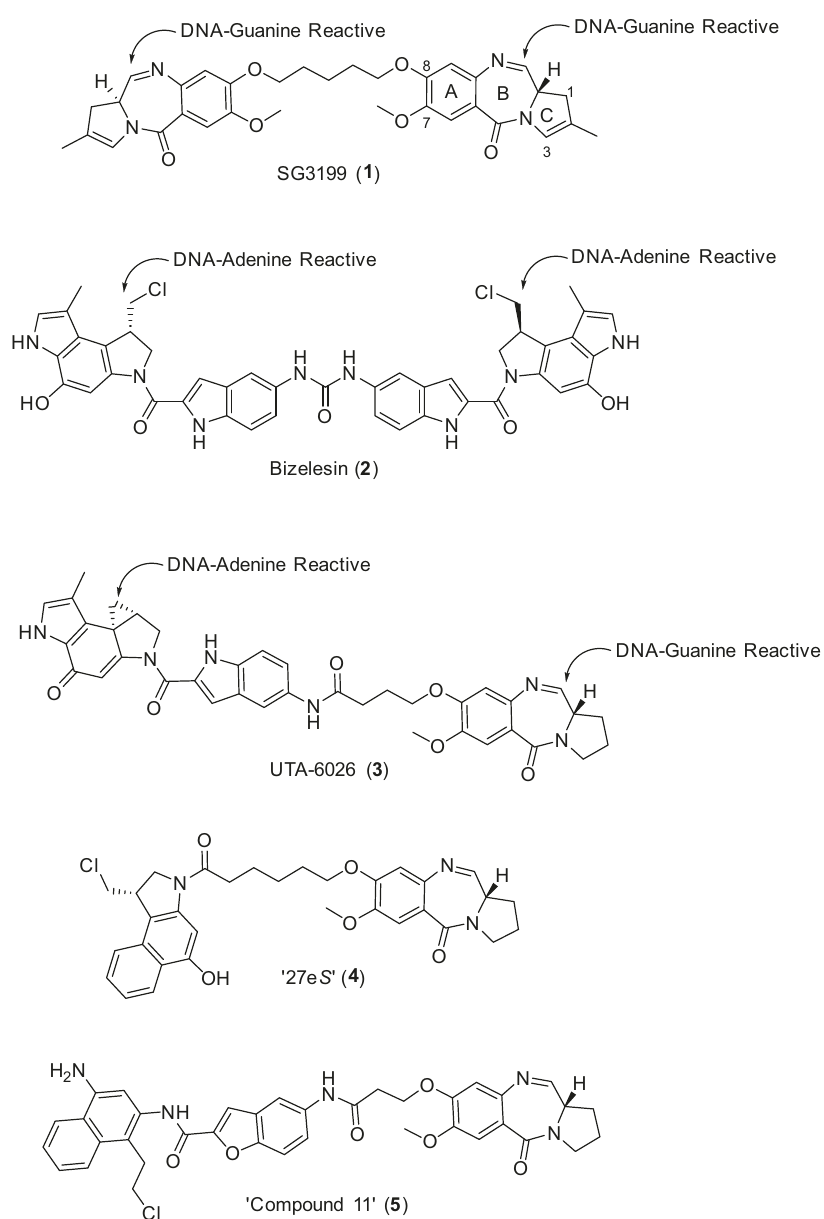
Fig. 1 Structures of previously published G-G and G-A DNA cross-linking agents. ( 1 ) The DNA G-G cross-linking PBD dimer SG3199, the ADC-payload component of Tesirine. ( 2 ) The A – A cross-linking agent Bizelesin, a cyclopropapyrroloindole (CPI) dimer shown in its bis -chloromethyl seco (prodrug) form. The three published families of CXI-PBD dimers capable of cross-linking Guanine and Adenine DNA bases: The Hurley et al. ( 3 ) 11 , Tercel et al. ( 4 ) 12 and Lee et al. ( 5 ) 13 hybrid